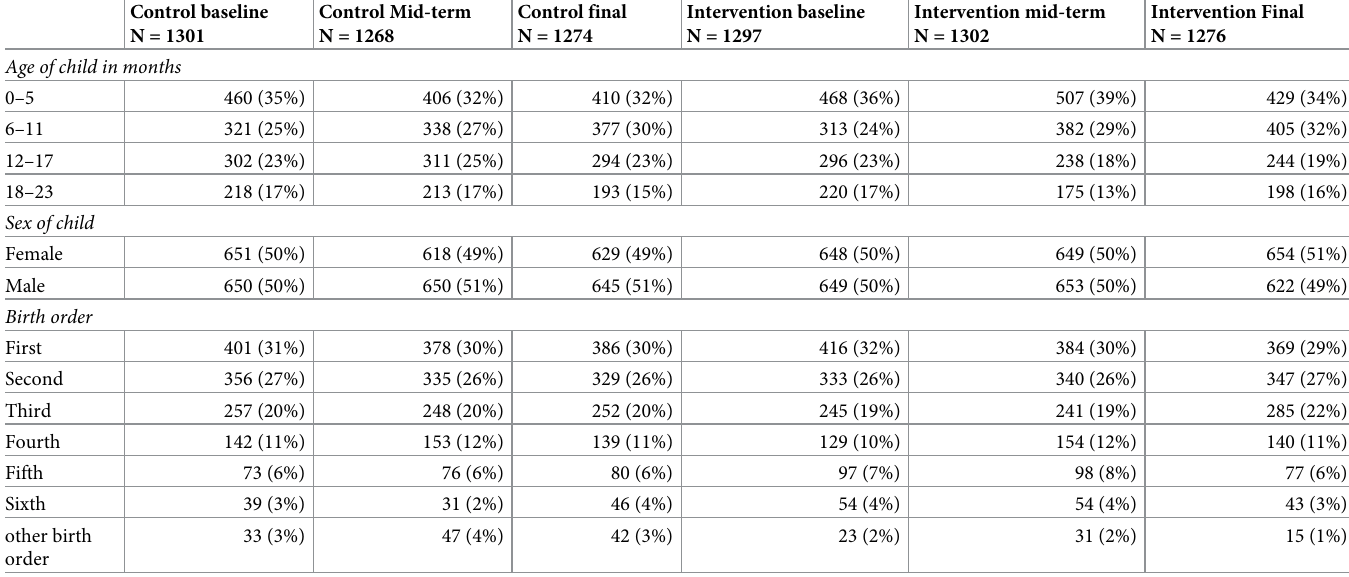
Table 2. Characteristics of the children by survey.